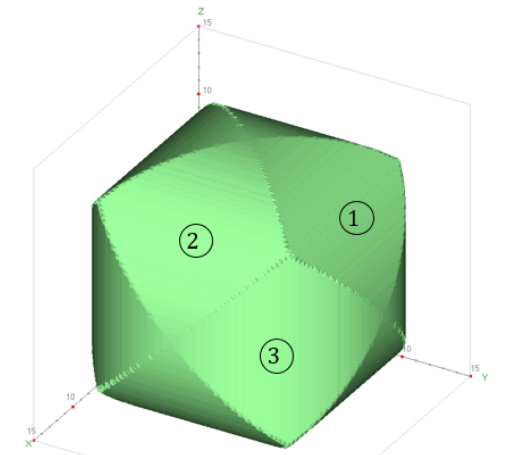
Figure 8. Theoretical